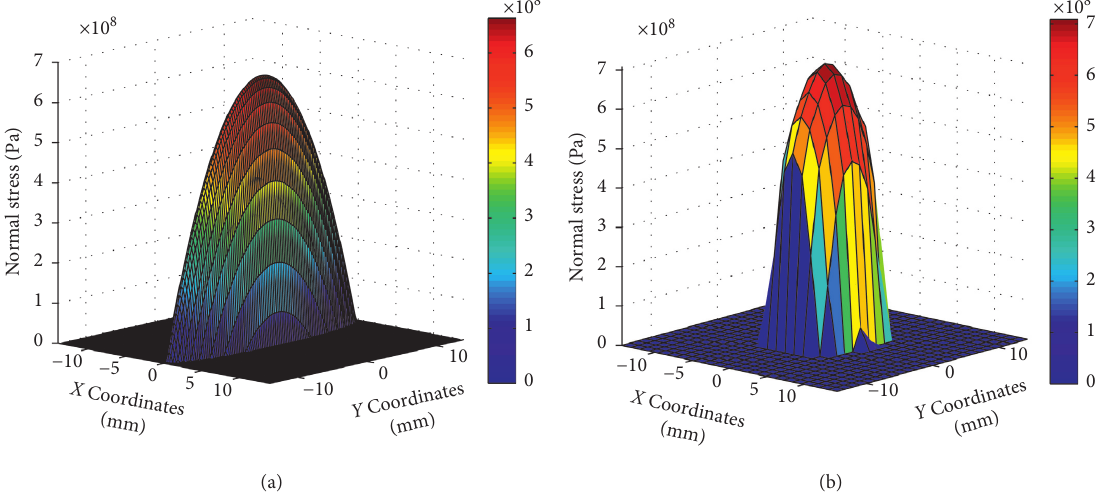
Figure 3: Contact pressure distribution (wheelset transverse displacement is − 6mm) based on: (a) Hertz; (b) non-Hertz.